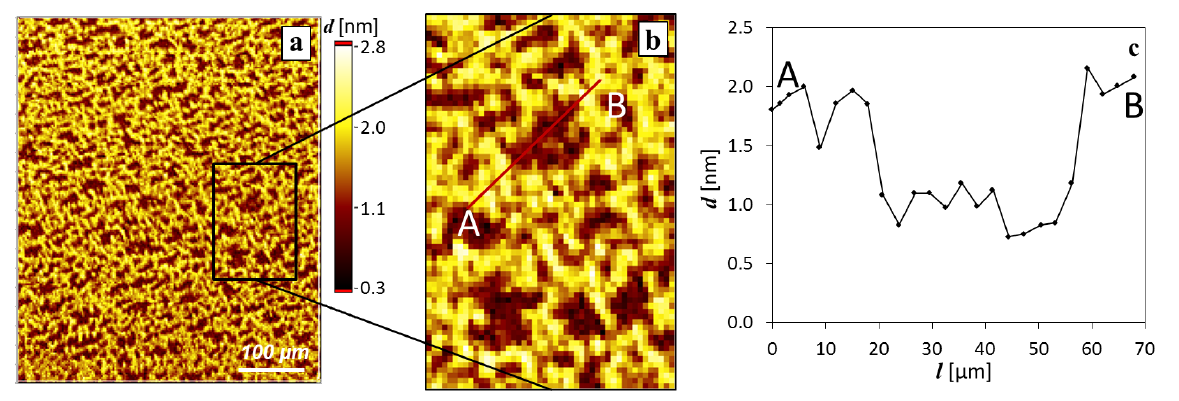
Figure 7: (a) Thickness map of PLGA network structures at 12 mN·m − 1 converted from the corresponding Δ -map in Figure 6b. (b) The section that is used for a (c) cross-section trace (red line).